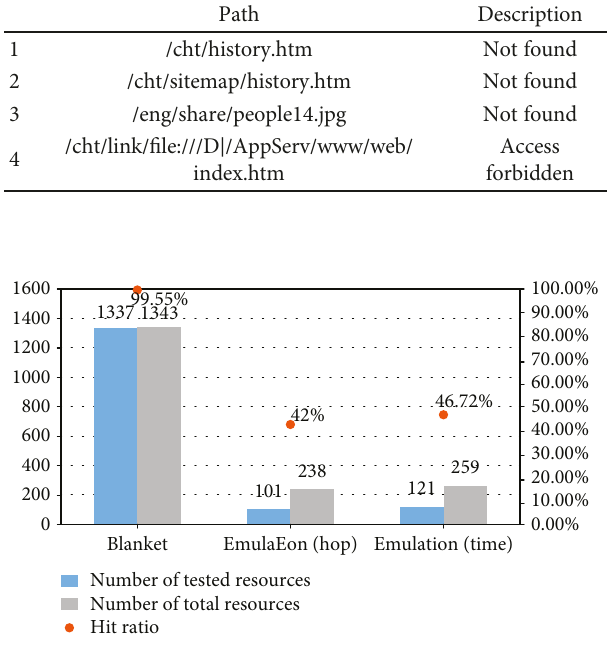
Figure 16: Comparison of coverage between di ff erent test modes.